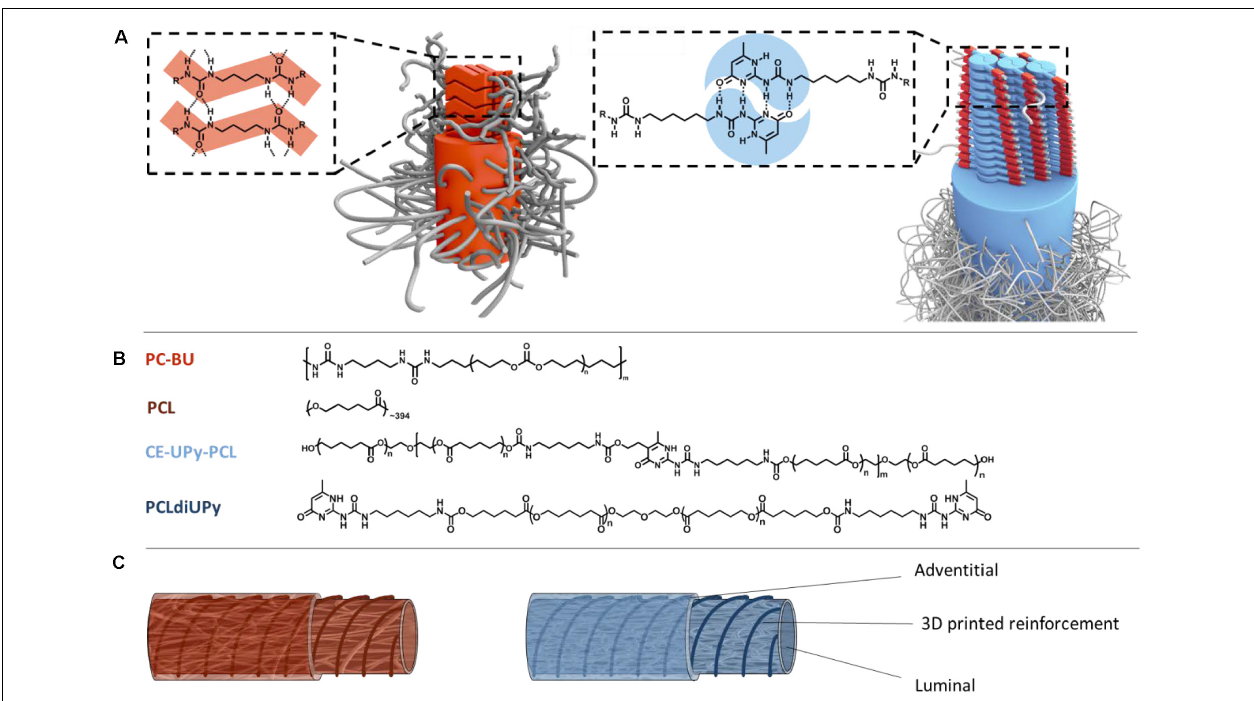
FIGURE 1 | Schematic representation of anti-kinking graft design from supramolecular systems. (A) Bisurea-bisurea interactions through hydrogen bonds (in red) and UPy-UPy dimerization through quadruple hydrogen bonding. (B) Bisurea functionalized polycarbonate (PC-BU) ( M n = 21 kg/mol). Polycaprolactone (PCL) ( M n = 45 kg/mol). Chain-extended UPy-modified polycaprolactone (CE-UPy-PCL) ( M n = 15 kg/mol). End-modified bifunctionalized UPy-polycaprolactone with urethane bonds (PCLdiUPy) ( M n = 3 kg/mol). (C) Schematic illustration of the anti-kinking vascular graft design consisting on two electrospun layers with a 3D printed strand between the layers for dimensional stability. One graft consists of PC-BU and PCL and the other a fully supramolecular graft consist of CE-UPy-PCL and